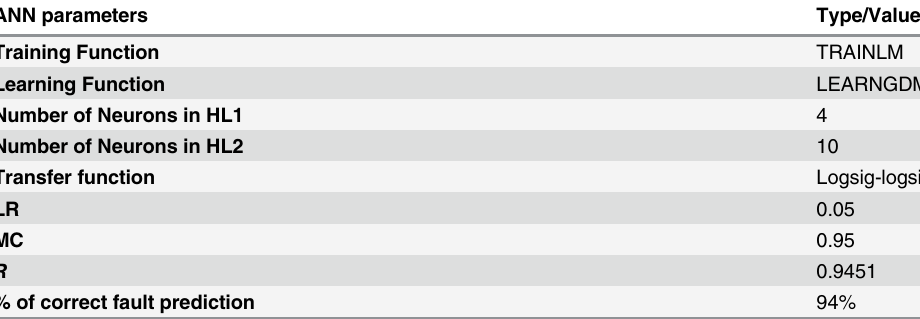
Table 3. Properties of the selected ANN using default LR and